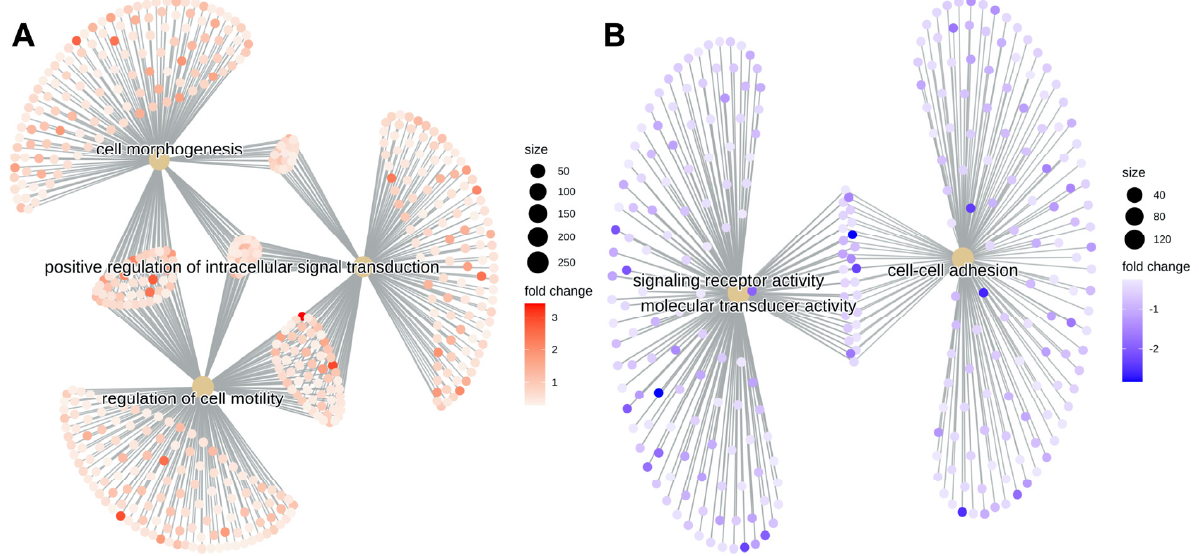
Figure 3. Category netplots depicting the linkages of differentially regulated genes and biological concepts (GO terms and KEGG pathways) as a network extracted from the next generation sequencing data of the Descemet membrane/endothelium complex (DmE, ( A ) and the stroma ( B ) of the donor corneas after 25 days of differential culture conditions in either 2%HPL or 2%FBS.